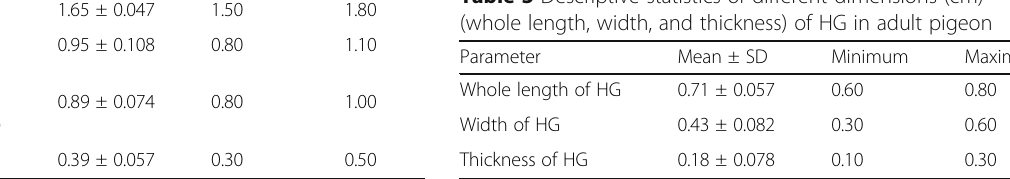
Table 3 Descriptive statistics of different dimensions